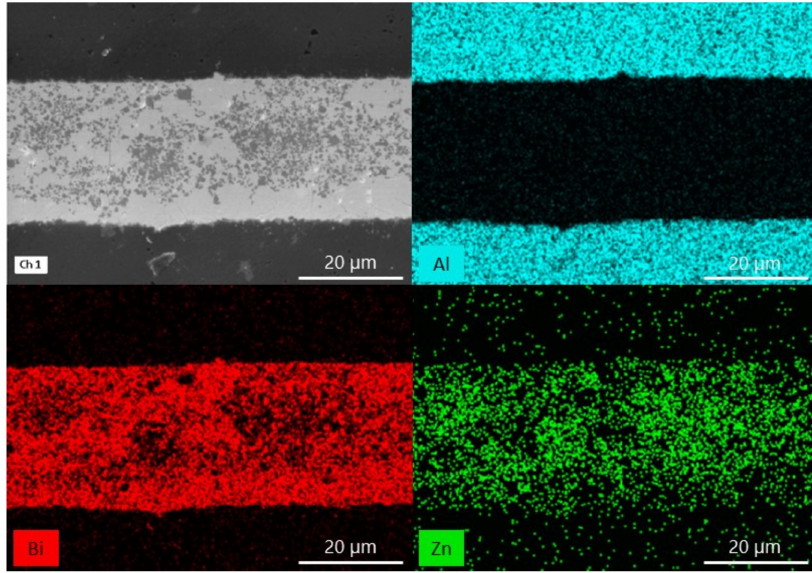
Figure 5. SEM-EDX analysis of the alumina bonded with Bi 2 O 3 -25% ZnO interlayer at 750 ◦ C.